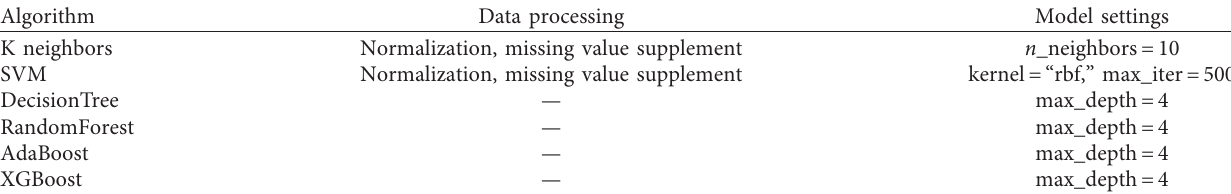
Table 4: Machine learning model data processing methods and model settings.